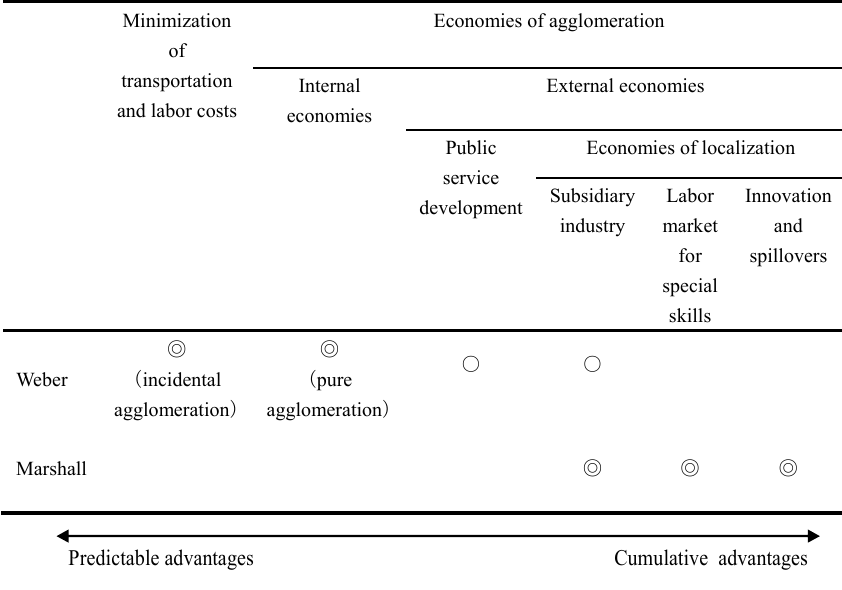
Table 1. The differences between Marshall and